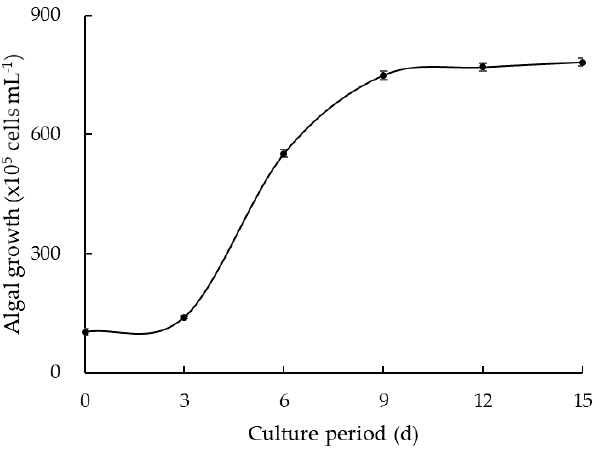
Figure 1. Growth curve of Microcystis aeruginosa in non-treated control group for 15 days of culture.